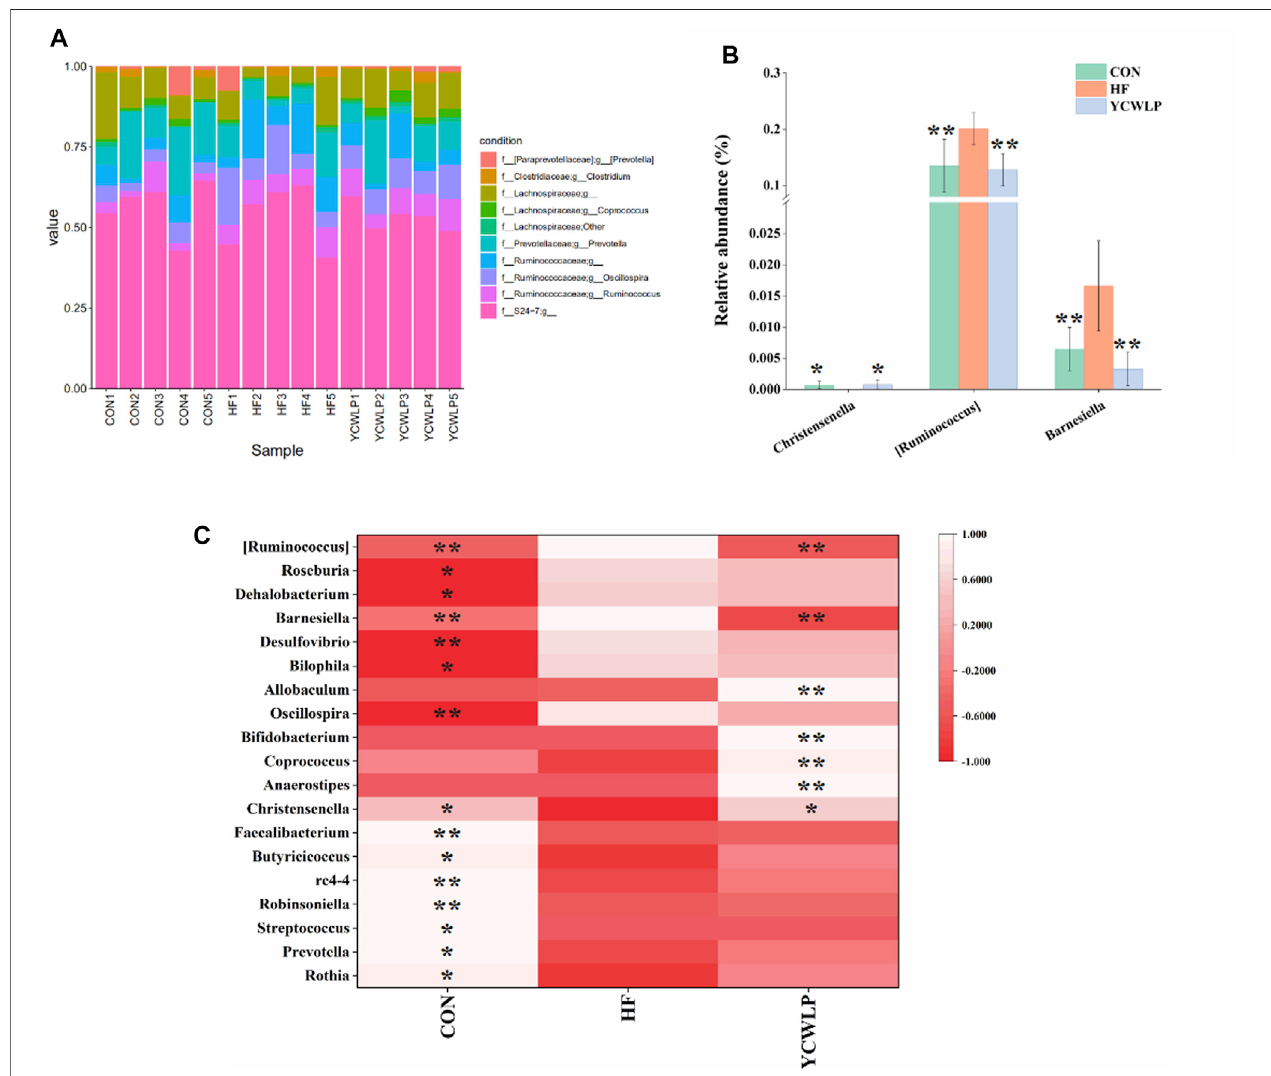
FIGURE3| Differences ofgutmicrobiota composition amongthe CON,HFand YCWLPgroups. (A) Topten gutmicrobiota intherelative abundanceat thegenus level; (B) The relative abundance of Christensenella [ Ruminococcus ] and Barnesiella ; (C) Heatmap of genera with signi fi cant variations; (D) The relative abundance of Anaerostipes , Coprococcus , Bi fi dobacterium and Allobaculum ; (E) Cladogram generated by the LEfSe analysis; (F) Linear discriminant analysis (LDA) scores of the discriminativetaxa.Thelettersp,c,o,fandgrepresentedphylum,class,order,familyandgenus,respectively.Signi fi cantdifferencecomparedwiththeHFgroup:* p -value < 0.05; ** p -value <